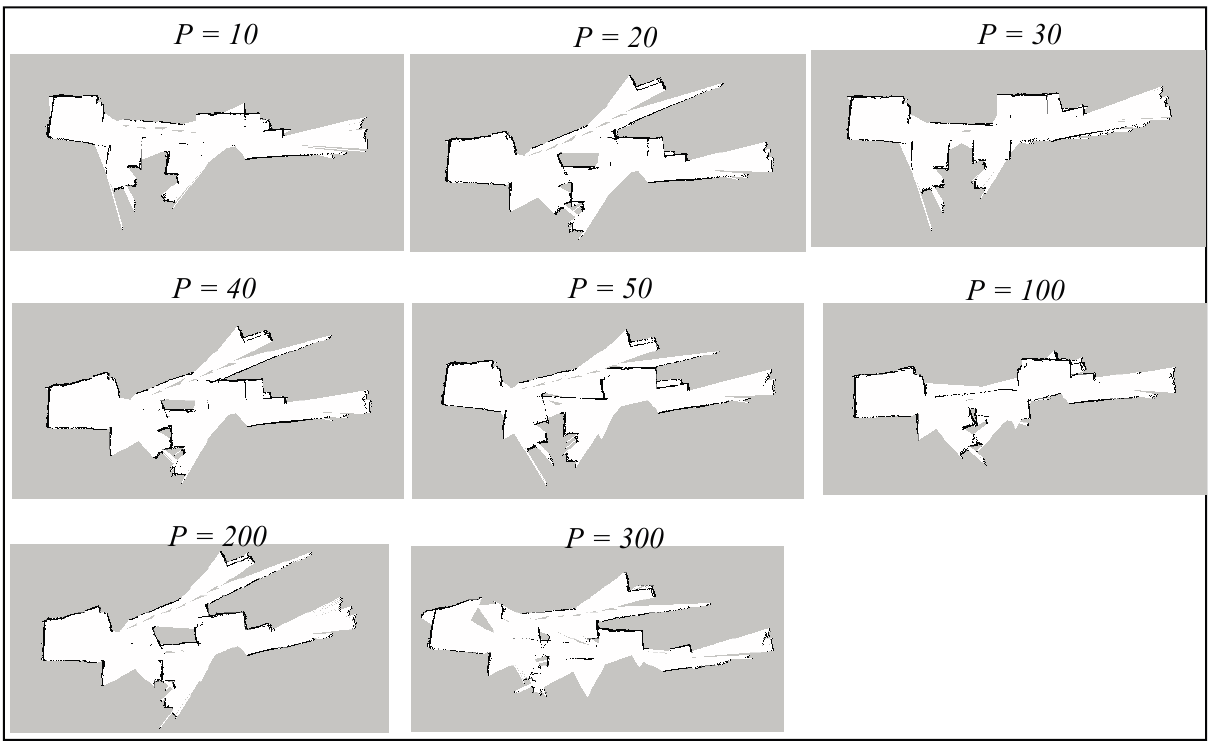
Figure 10. Corridor maps obtained using Gmapping technique with different number of